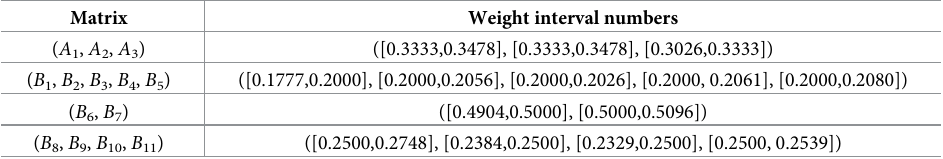
Table 8. Weight interval number of performance indices by improved method.